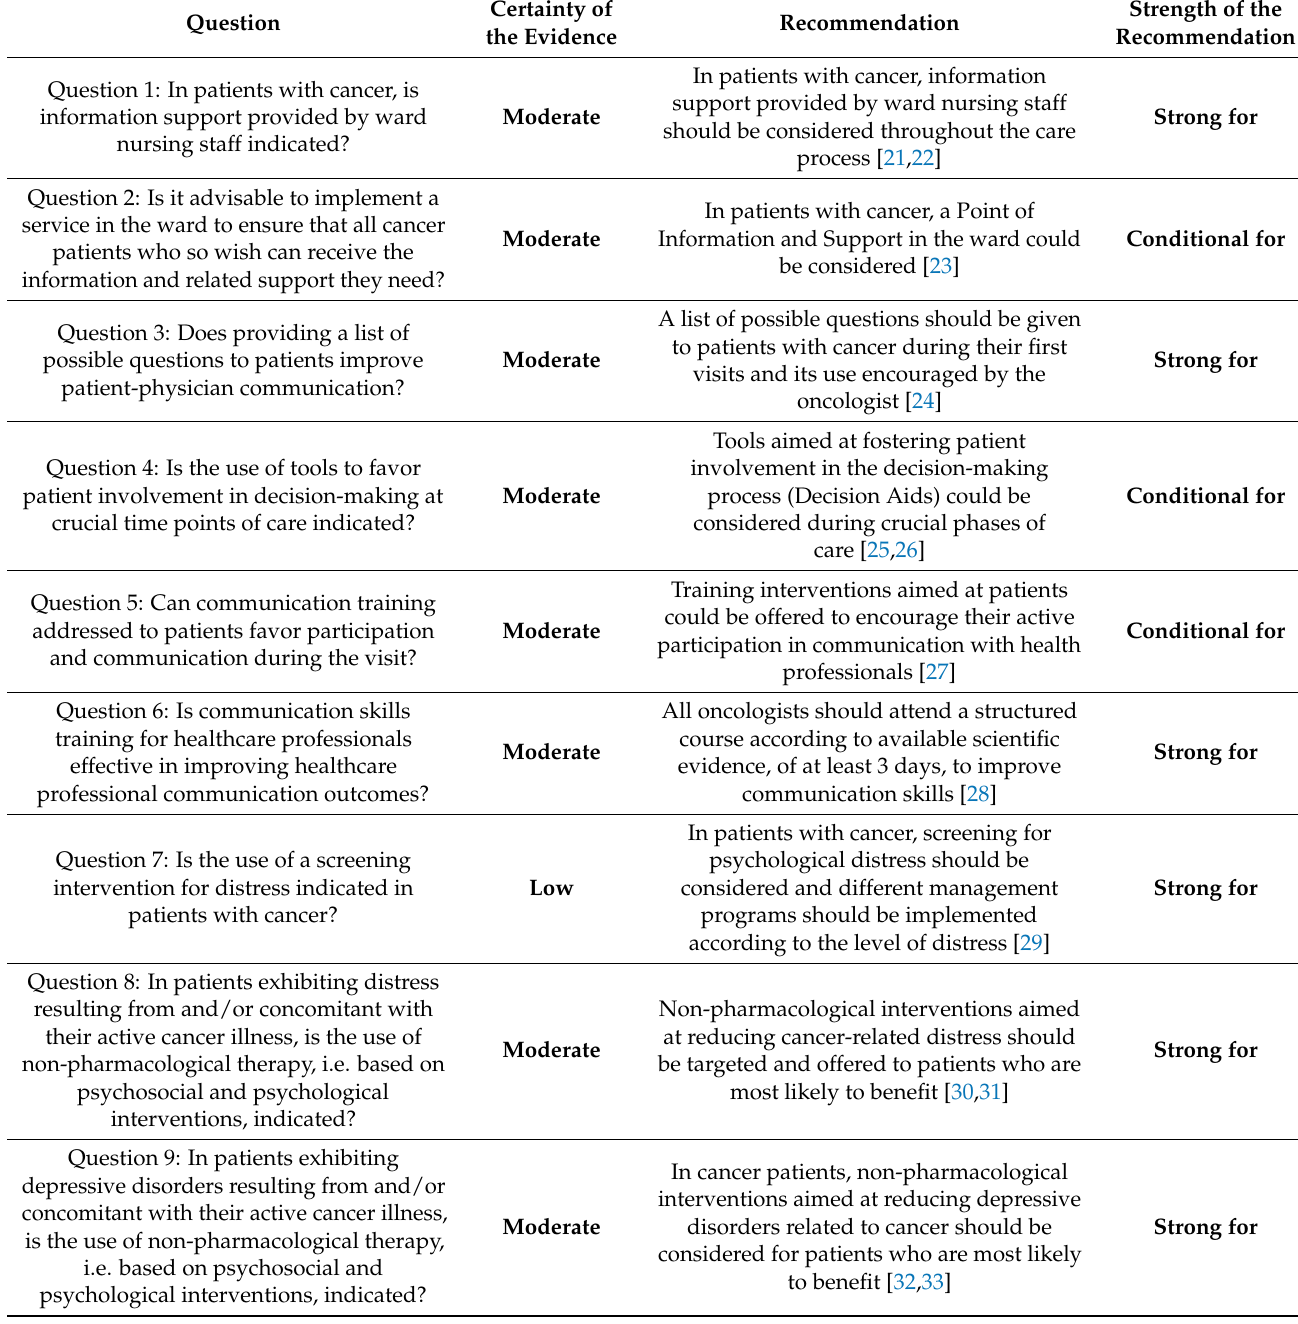
Table 3. Clinical recommendations for integrated psychosocial interventions into the routine care of patients with